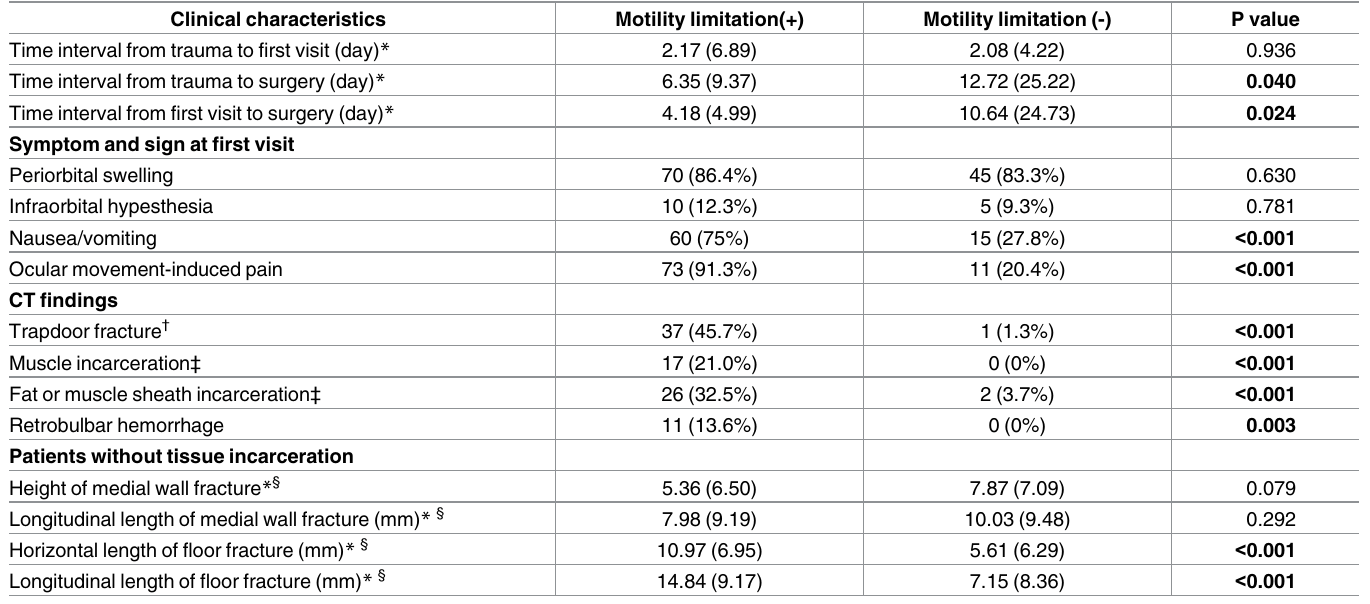
Table 2. Comparison of preoperative characteristics between groups with and without ocular motility